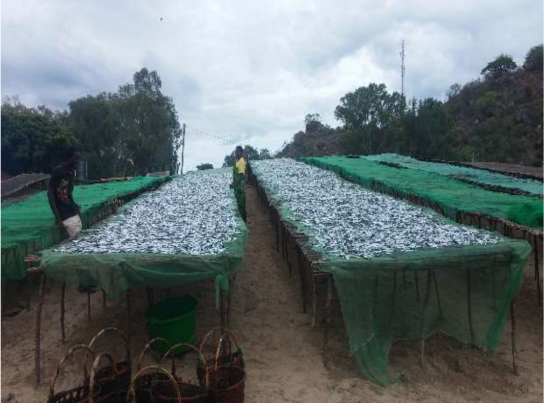
Figure 3. Fish ( usipa ) drying on mosquito